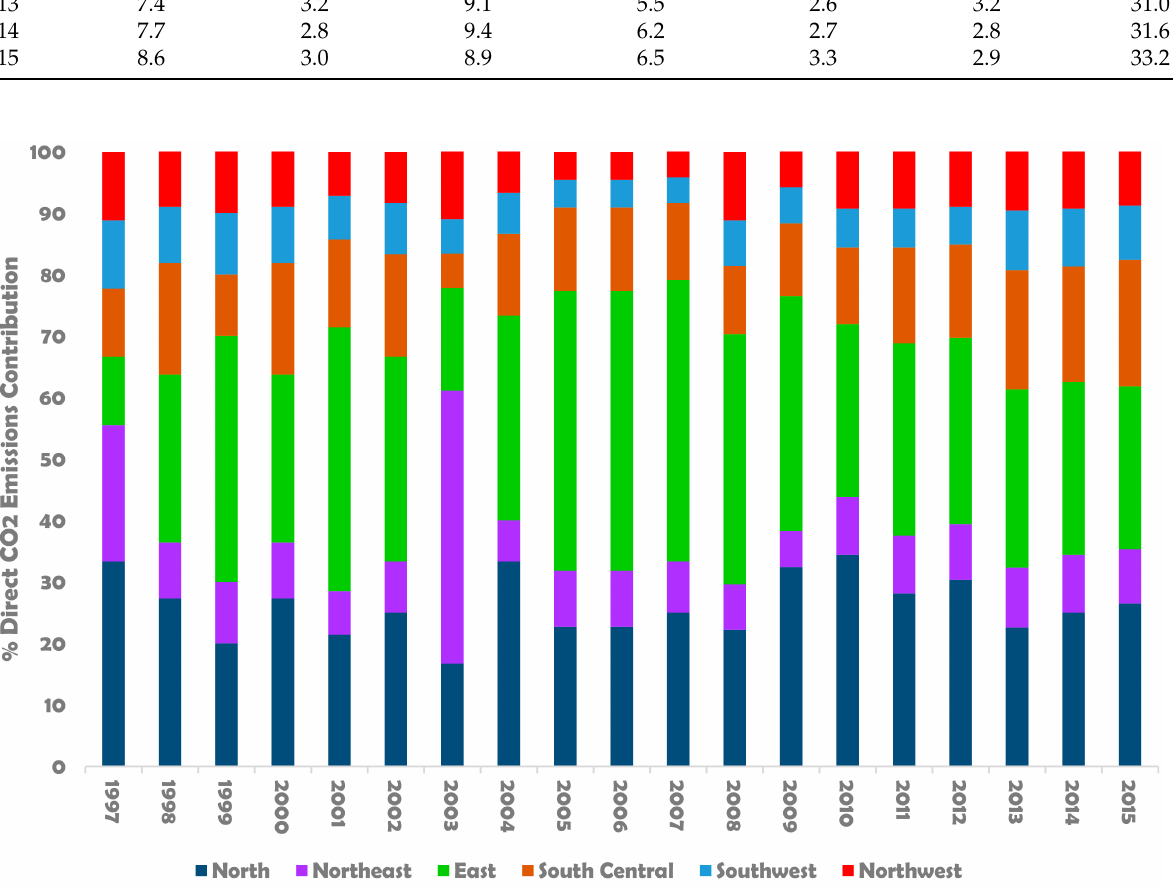
Figure 4. Changes in regional construction industry contributions to national direct CO 2 emissions from 1997 to